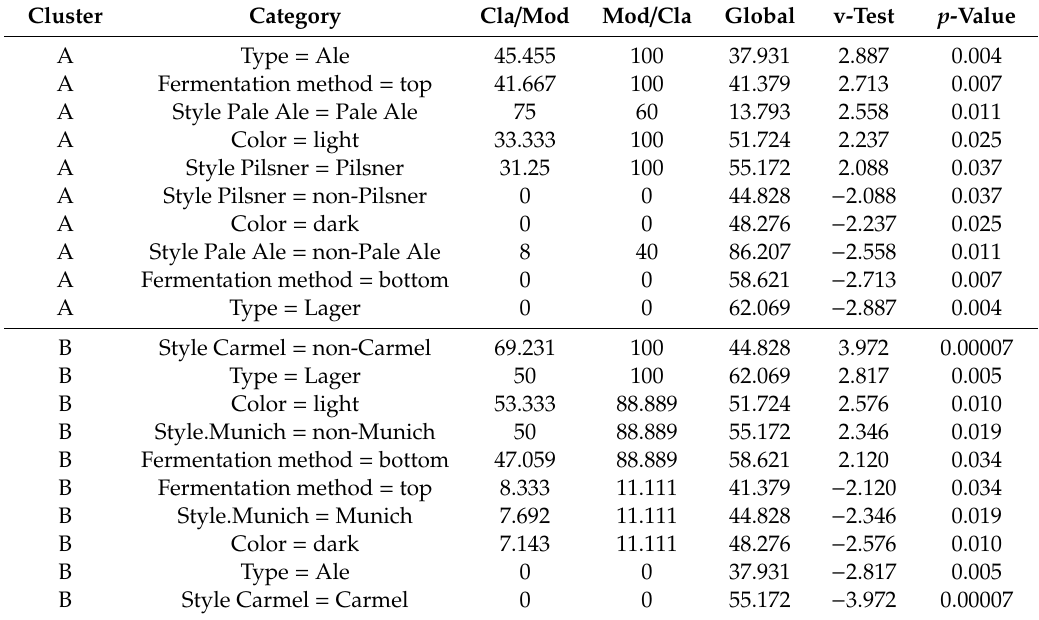
Table 5. Results for the hierarchical clustering on principal components. Description of each cluster by the categories. Only categories that characterize each cluster are shown ( p -value < 0.05). Values of the v-test are sorted from strongest to weakest significance in the construction of the given cluster, i.e., the higher the positive or the lower the negative value is the better / stronger description of the cluster it has. Cla / Mod indicates a ratio of beers with a specific category (modality) found in a cluster (class) to all beers with this category in the dataset (%). Mod / Cla indicates a ratio of beers having a specific category to all beers in a cluster. Global shows the percentage of beers having a specific category in the